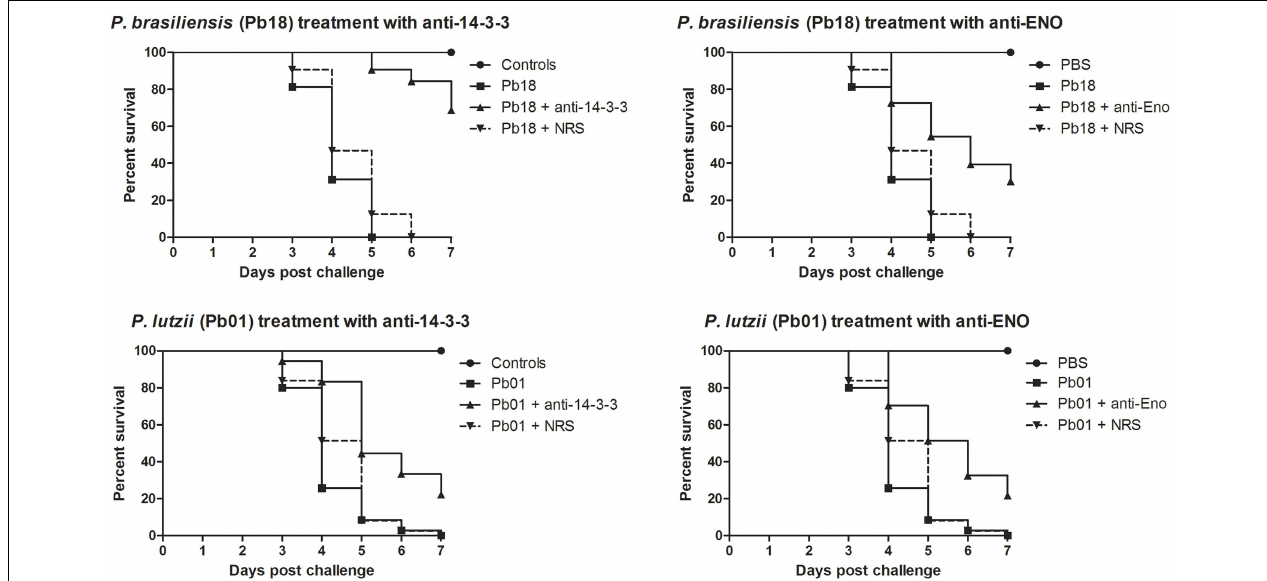
FIGURE 6 | Influence of adhesins on the virulence of the genus Paracoccidioides . Survival curve of G. mellonella larvae challenged with P. brasiliensis and P. lutzii and treated with 14-3-3 and enolase antibodies. Survival was evaluated for 7 days after challenge and showed a reduction in the virulence of the fungi when treated with the antibodies, with a statistically significant difference compared to untreated P. brasiliensis and P. lutzii ( p < 0 . 05 ). There were 6 different